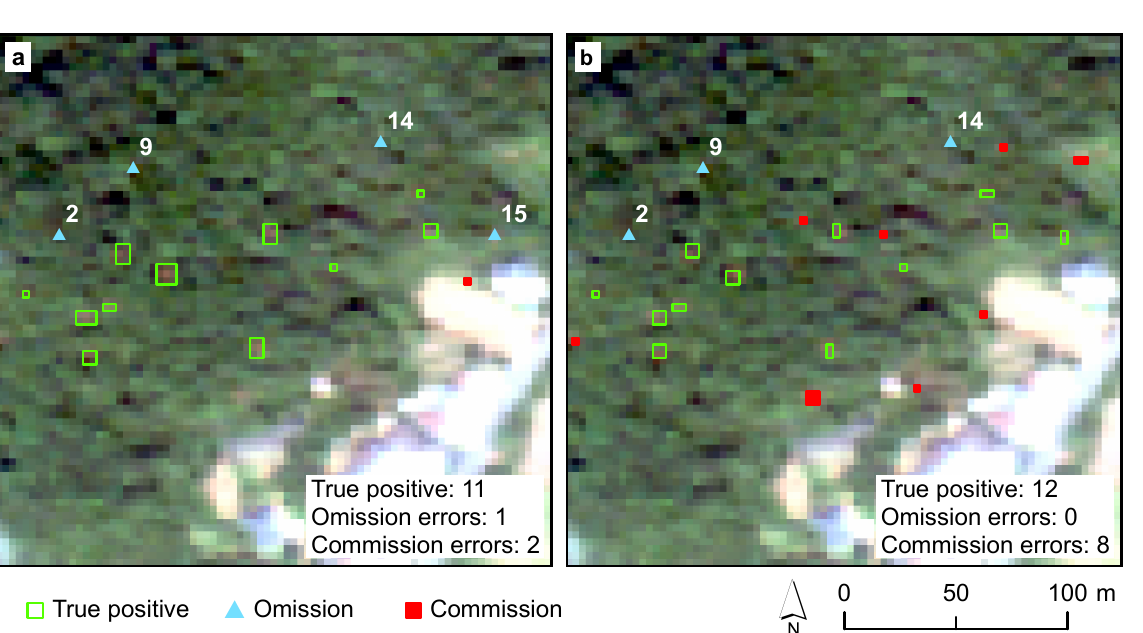
Figure 9. Comparison of the detection result through spatiotemporal change detection method ( a ) and single-date image classification method ( b ) at Site